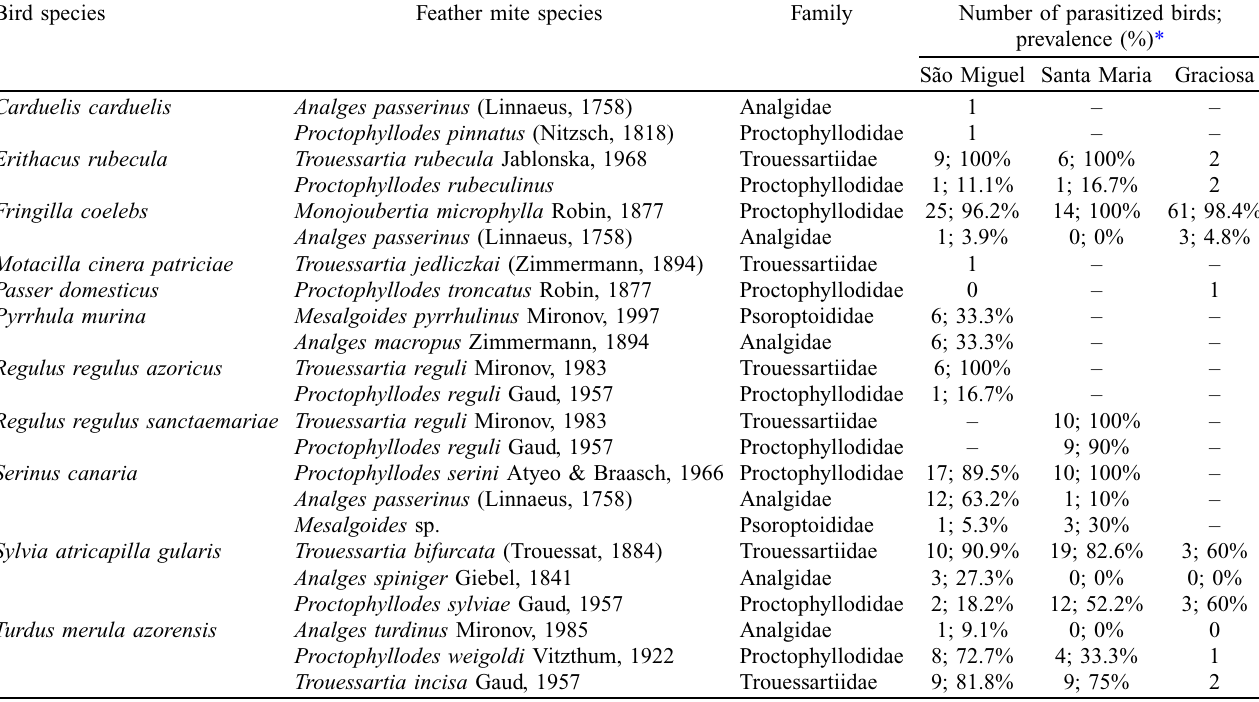
Table 2. Host species and prevalence of identified avian feather